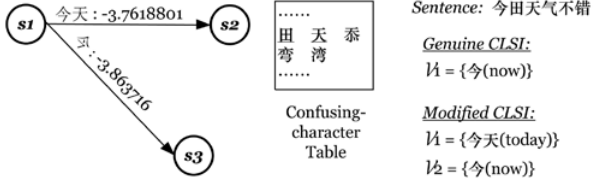
Figure 11: An Example to Show the Use of the Confusing-Character Table.